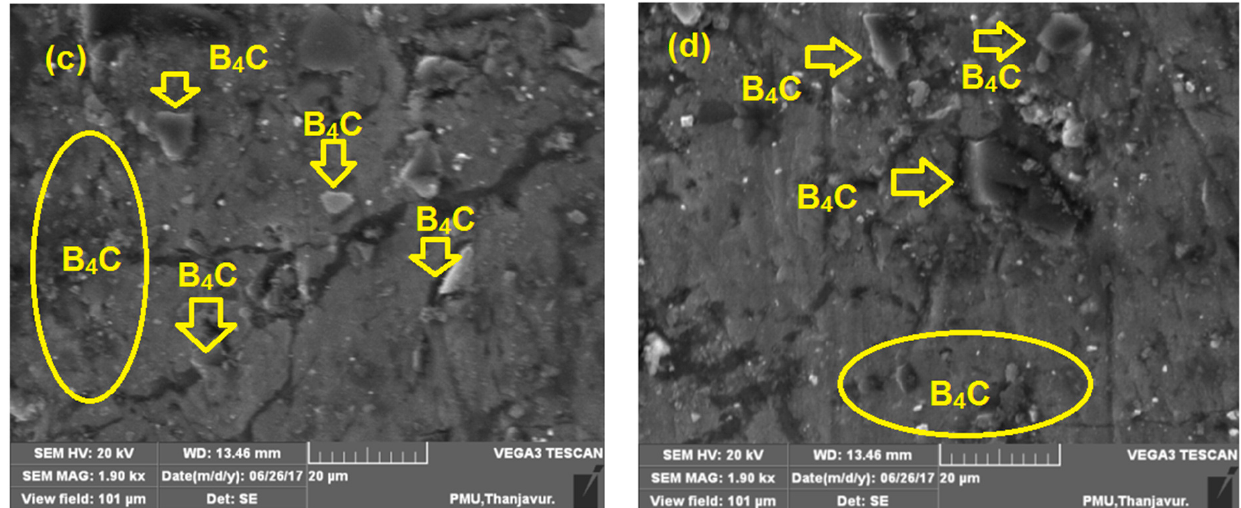
Figure 10. SEM images after compression test ( a ) 0%, ( b ) 5% B 4 C, ( c ) 10% B 4 C, and ( d ) 15% B 4 C